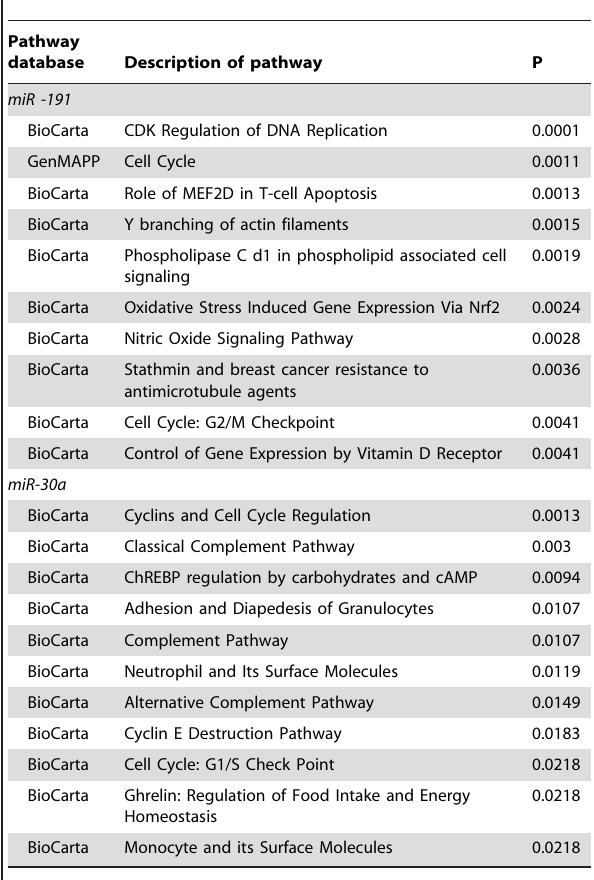
Table 1. Top ten pathways identified by pathway enrichment analysis for miR-30a and -191